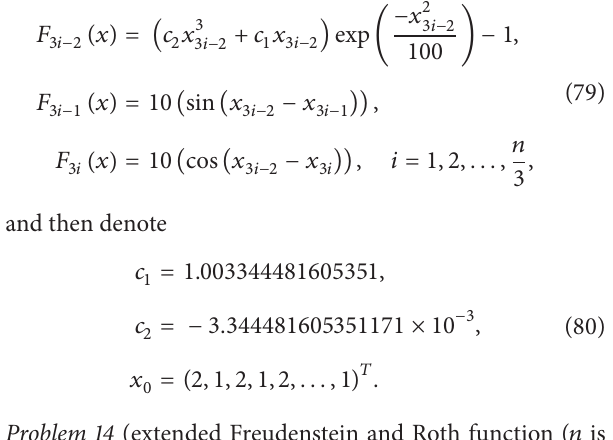
Algorithm 3 terminated successfully. The numerical